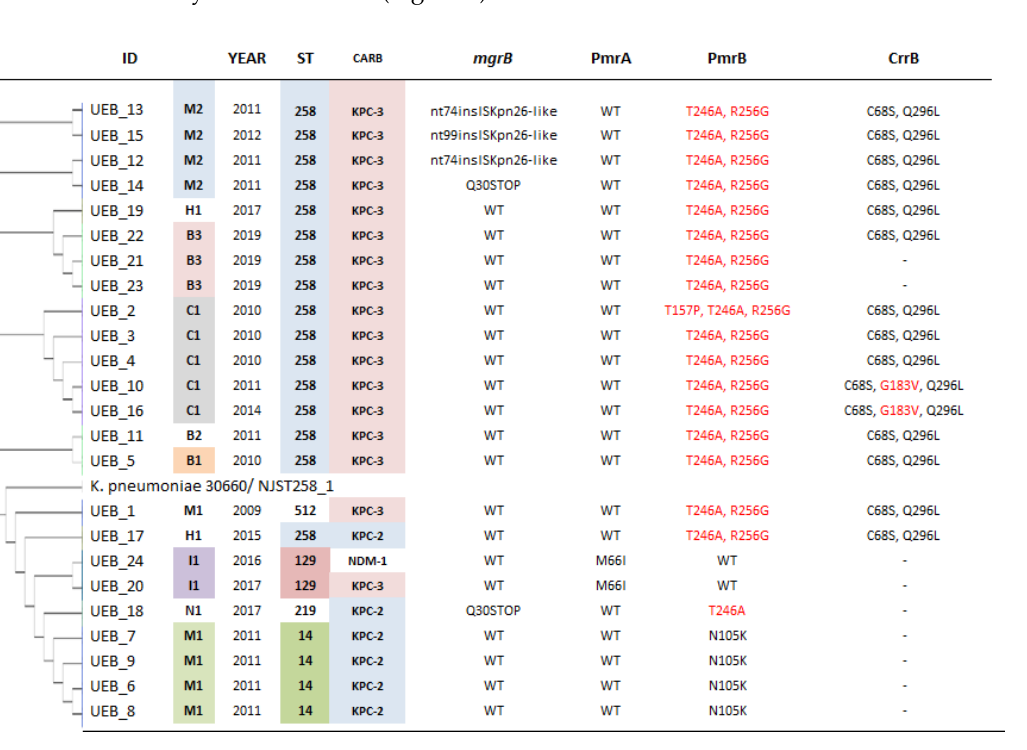
Figure 2. Characteristics of polymyxin resistant K. pneumoniae isolates included in this study. C1: Cali, M1: institution 1 Medellin, M2: institution 2 Medellin, B1: Institution 1 Bogotá, B2: institution 2 Bogotá, B3: institution 3 Bogotá, N1: Neiva, I1: Ibague, H1: Pasto. Mutations previously reported associated with polymyxin resistance are highlighted in red. Q30STOP: Premature stop codon at 30 th amino acid. The interactive tree of life (iTOL) tool was used for the phylogenetic tree display and annotation. Bootstrap values shown in Supplemental Figure 2.